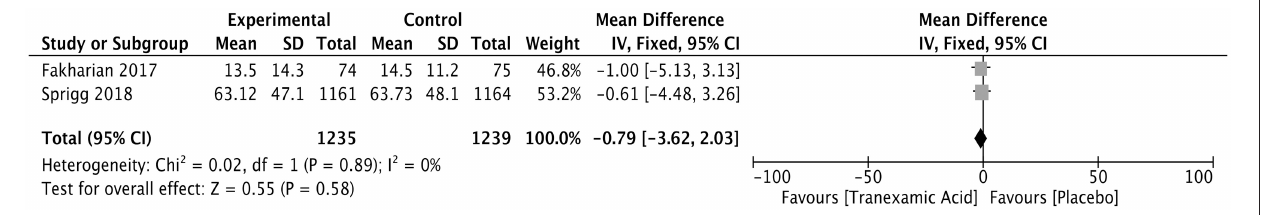
FIGURE 8 | Forest plot of the comparison between tranexamic acid and placebo treatments for the duration of hospital